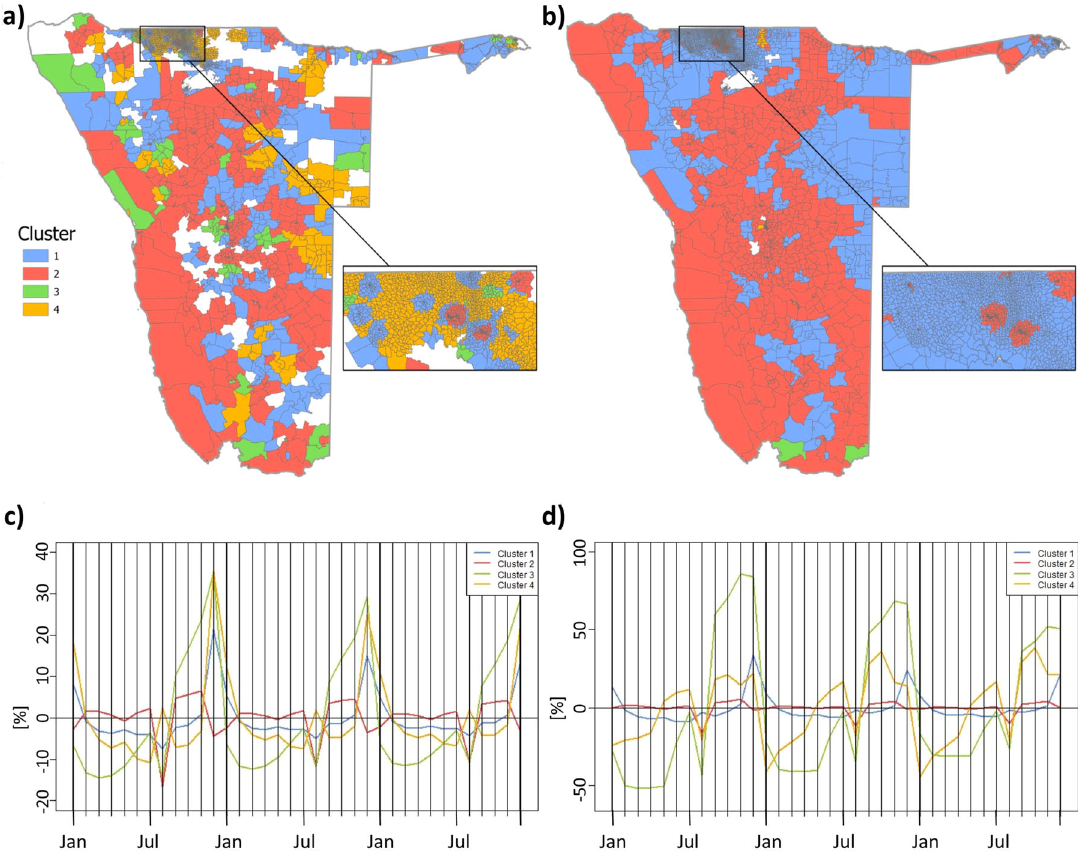
Fig. 7 Grouping of administrative units into four clusters at level 3. a Spatial distribution of clusters using Tower Ranges, b spatial distribution of clusters using Adjusted Voronois, c average seasonal user proportion per cluster from 2011 to 2013 using Tower Ranges, and d average seasonal user proportion per cluster from 2011 to 2013 using Adjusted Voronois. Administrative areas without fi ll colour have no